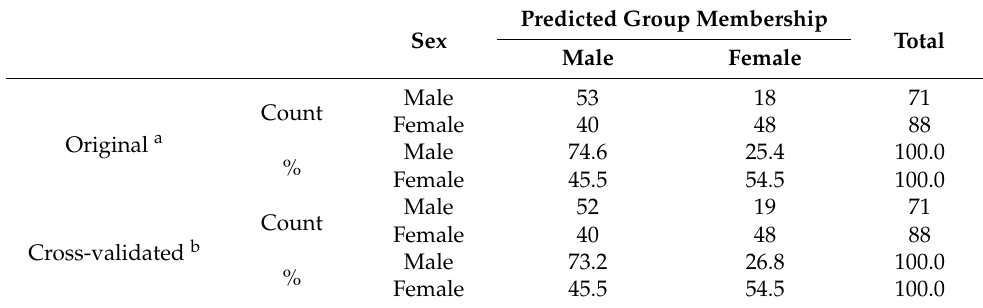
Table 7. Percentage predictability for group